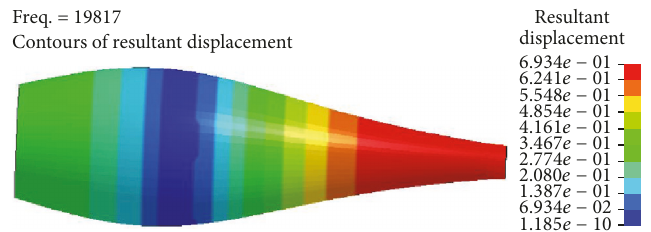
Figure 8: The mode shape for the natural frequency of 𝑓 = 19 , 817 Hz.